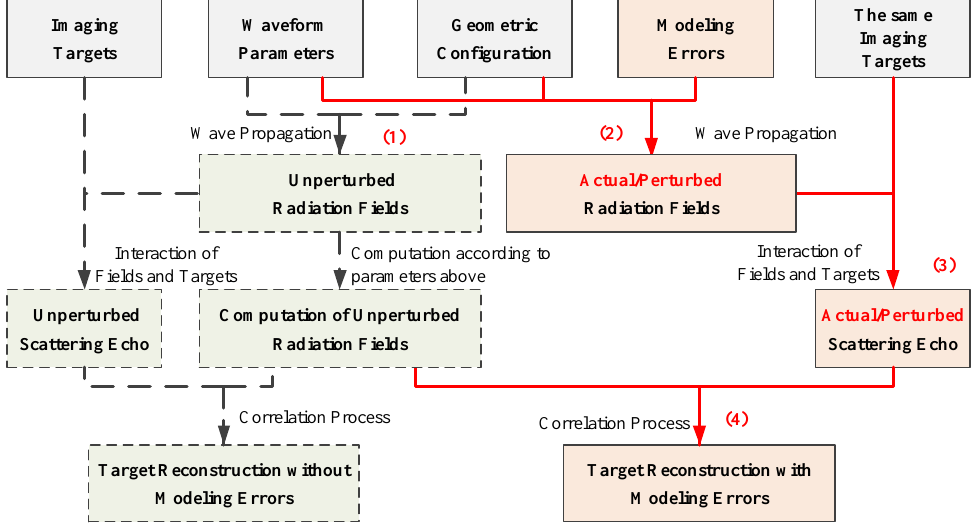
Figure 4. Imaging procedure of MSCI with modeling